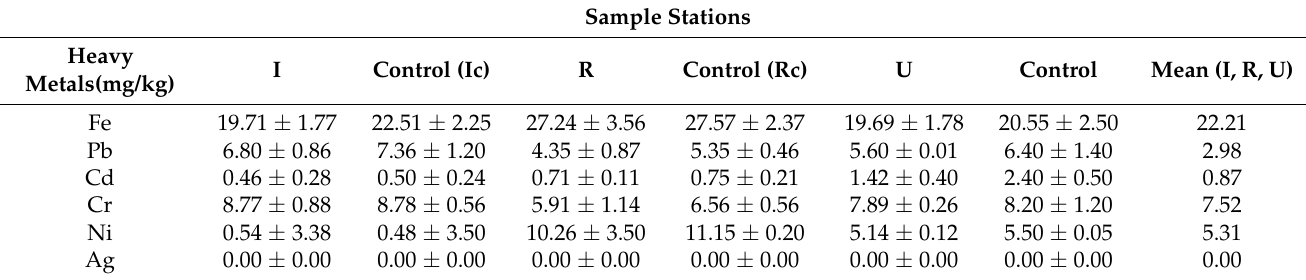
Table 1. Mean concentration of heavy metals in soils of campuses (I, R, U). Sample Stations